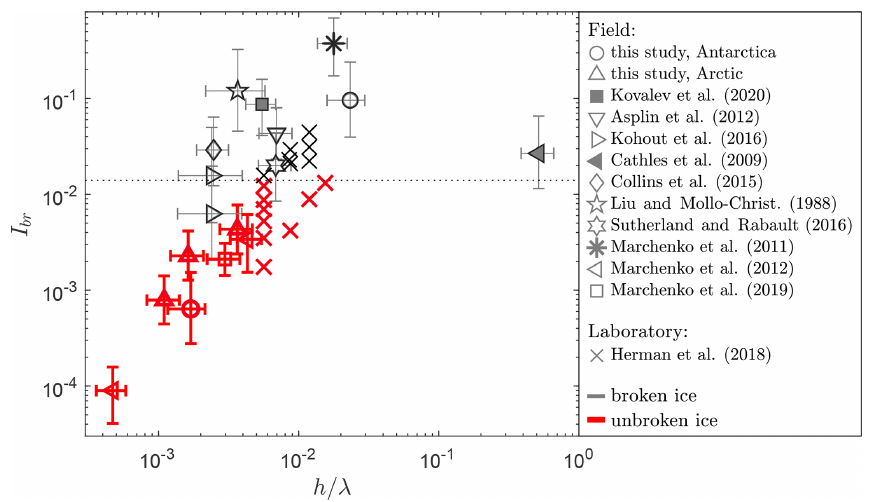
Figure 8. Observations of I br against the relative ice thickness h/λ for the complete data set. Events of wave-induced sea ice break-up are indicated with black markers, whereas observations where the flexural motion did not lead to break-up of the sea ice are shown with red markers. The observational threshold value I br ≈ 0 . 014, which separates the break-up from the non-break-up events, is indicated by the dashed